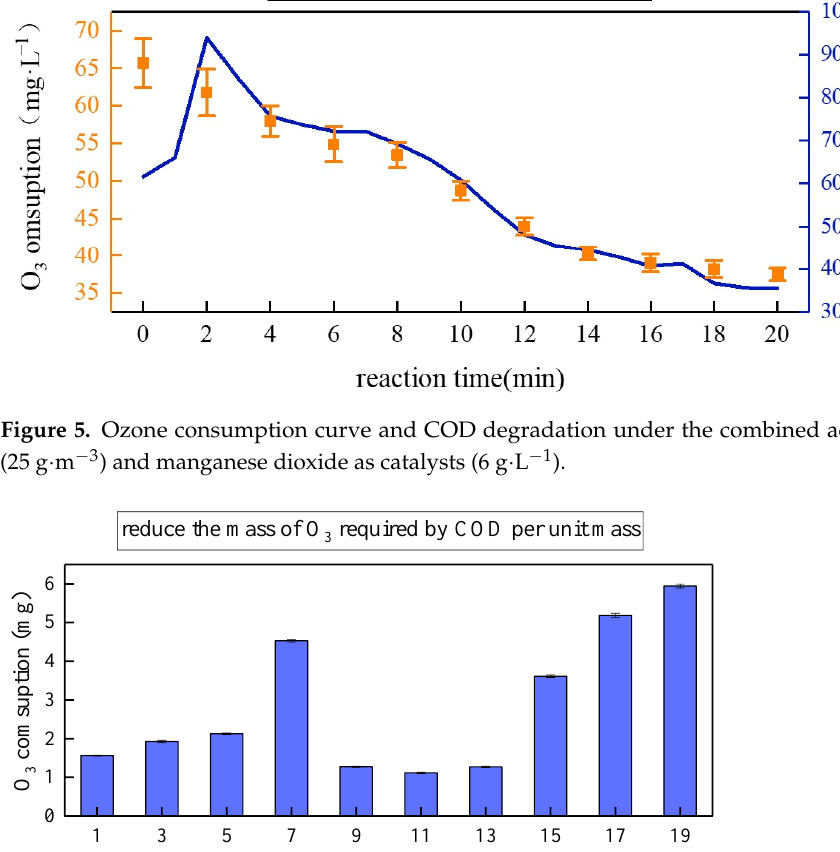
Figure 6. Ozone utilization change under the combined action of ozone (25 g·m − 3 ) and manganese dioxide as catalysts (6 g·L − 1 ).